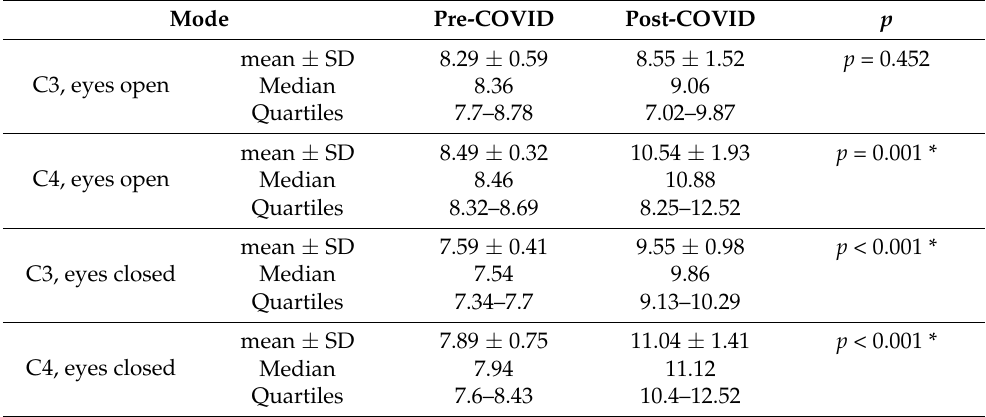
Table 2. The results of the Theta waves examination (waves from C3, C4